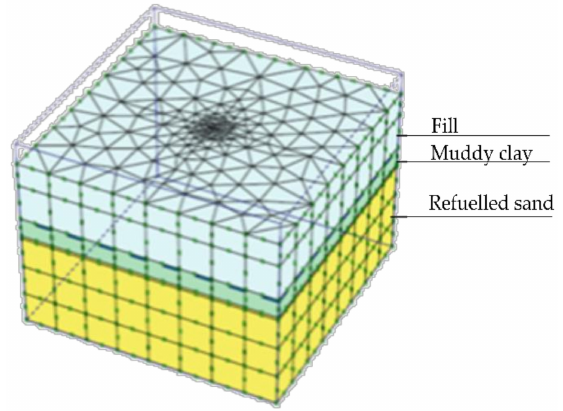
Figure 10. Finite element mesh for